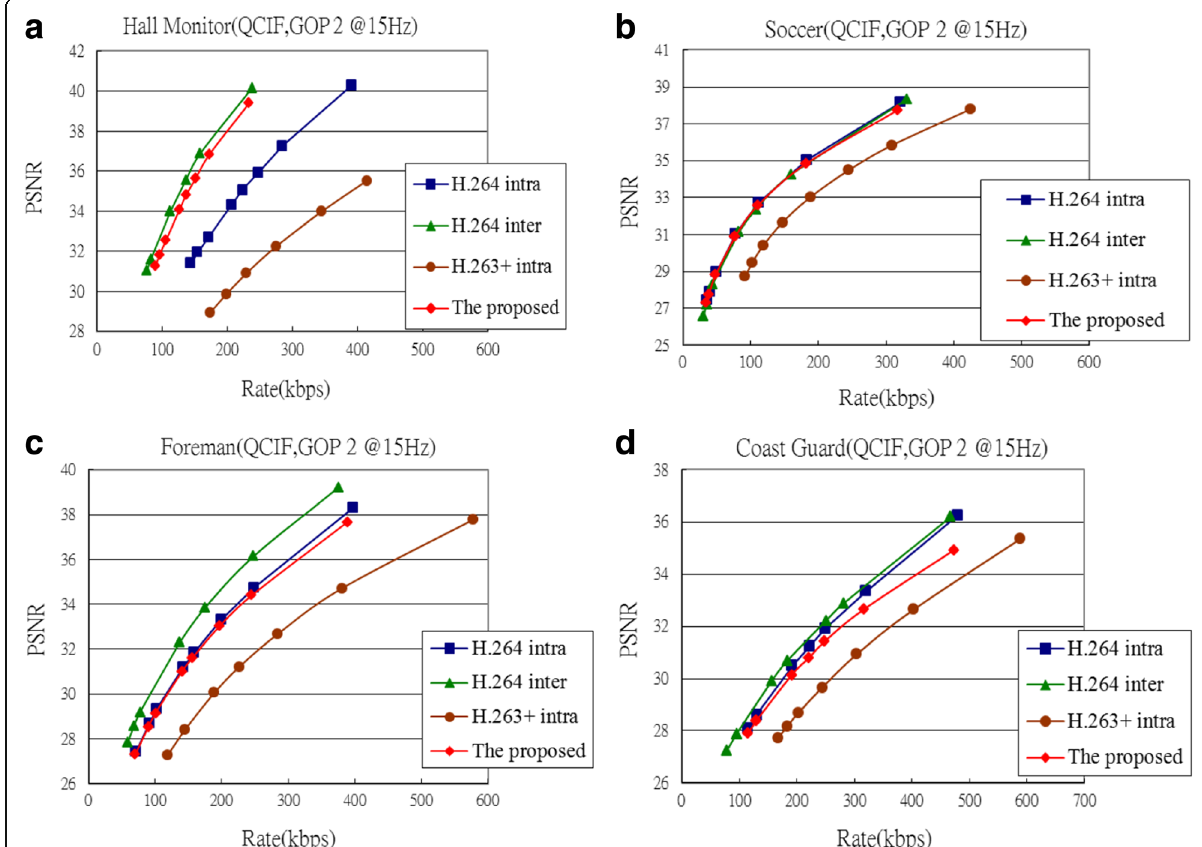
Fig. 10 The RD performance of the proposed scheme compared to that of H.264/AVC and H.263+ in GOP